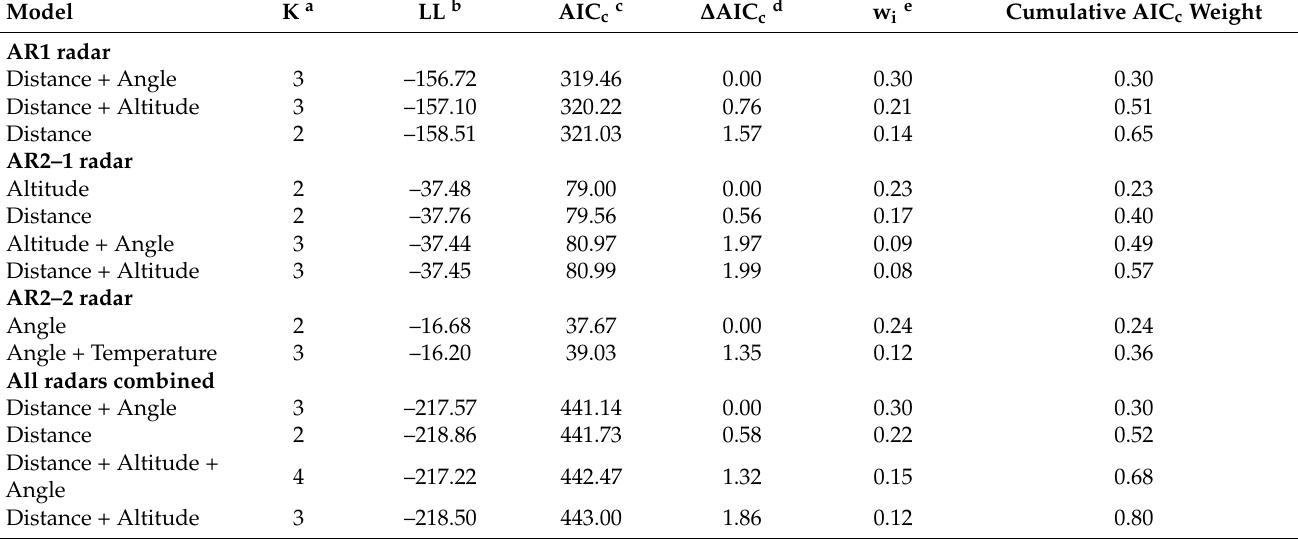
Table 1. Top logistic regression models of red-tailed hawk locations among three radar sensors (AR1, AR2-1, and AR2-2), ranked by Akaike’s Information Criterion adjusted for small sample size (AICc), predicting radar track (matching) during a study at Chicago’s O’Hare International Airport from